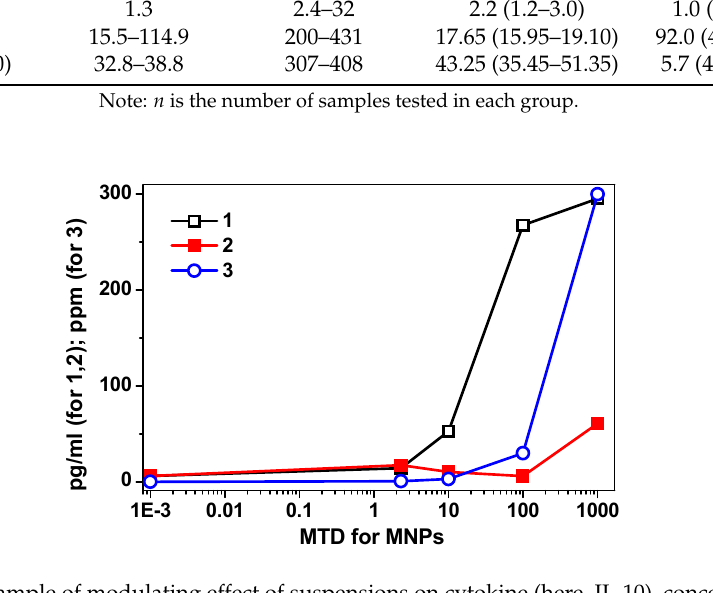
Figure 6. An example of modulating effect of suspensions on cytokine (here, IL-10), concentrations are given for 24-h HBMLs culture. Curve 1 corresponds to the FF1 suspension without chitosan, curve 2 corresponds to the FF2 suspension with chitosan and curve 3 shows correlation between calculated dependence of iron concentration in MTDs in ppm.